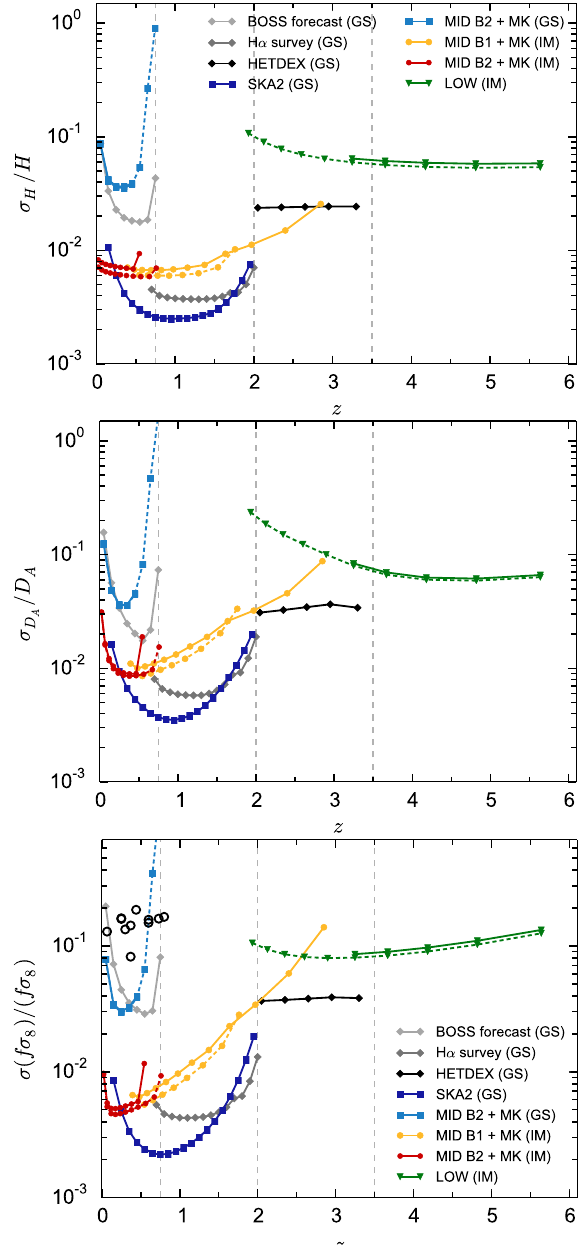
Figure 14. Forecasted constraints on radial ( H ) and angular ( D A ) BAO and the growth of structures ( f σ 8 ) from Square Kilometer Array (SKA) as compared with other surveys. “GS” stands for galaxy survey while “IM” for intensity mapping survey (H α survey is a Euclid-like survey). Forecasts from Reference [35] where more information can be